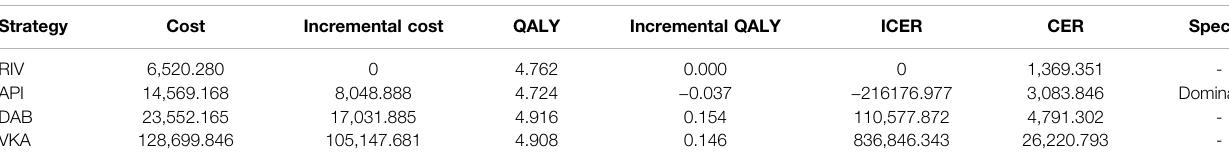
TABLE 6 | Cost-effectiveness results of Markov